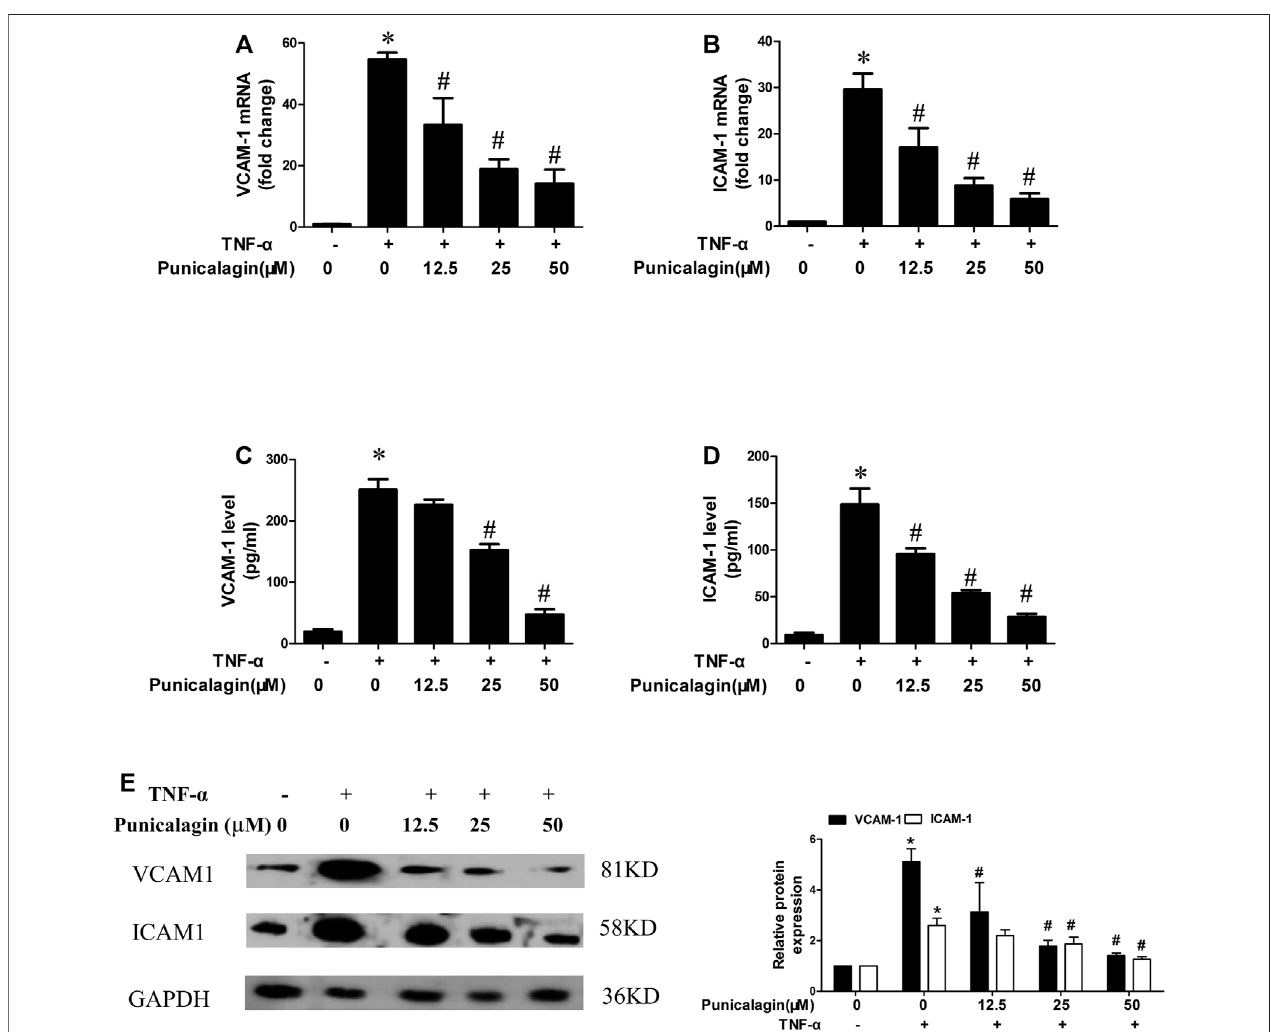
FIGURE 2 | Effect of punicalagin on expressions of VCAM-1 and ICAM-1 in TNF- α -stimulated HUVECs. HUVECs were pretreated with punicalagin and stimulated by TNF- α (10 ng/ml) for 24 h (A, B) Gene expression of VCAM-1 and ICAM-1 in HUVECs determined quantitatively using qRT-PCR. (C, D) The secreted protein of VCAM-1 and ICAM-1 in the supernatant of each group was detected by ELISA. Western blot analysis of VCAM-1 and ICAM-1 in HUVECs treated with or without punicalagin after treatment with or without 10 ng/ml TNF- α for 8 h (E) . The results were performed in triplicate. * p < 0.05 vs. HUVECs without TNF- α , # p < 0.05 vs treatment with TNF- α